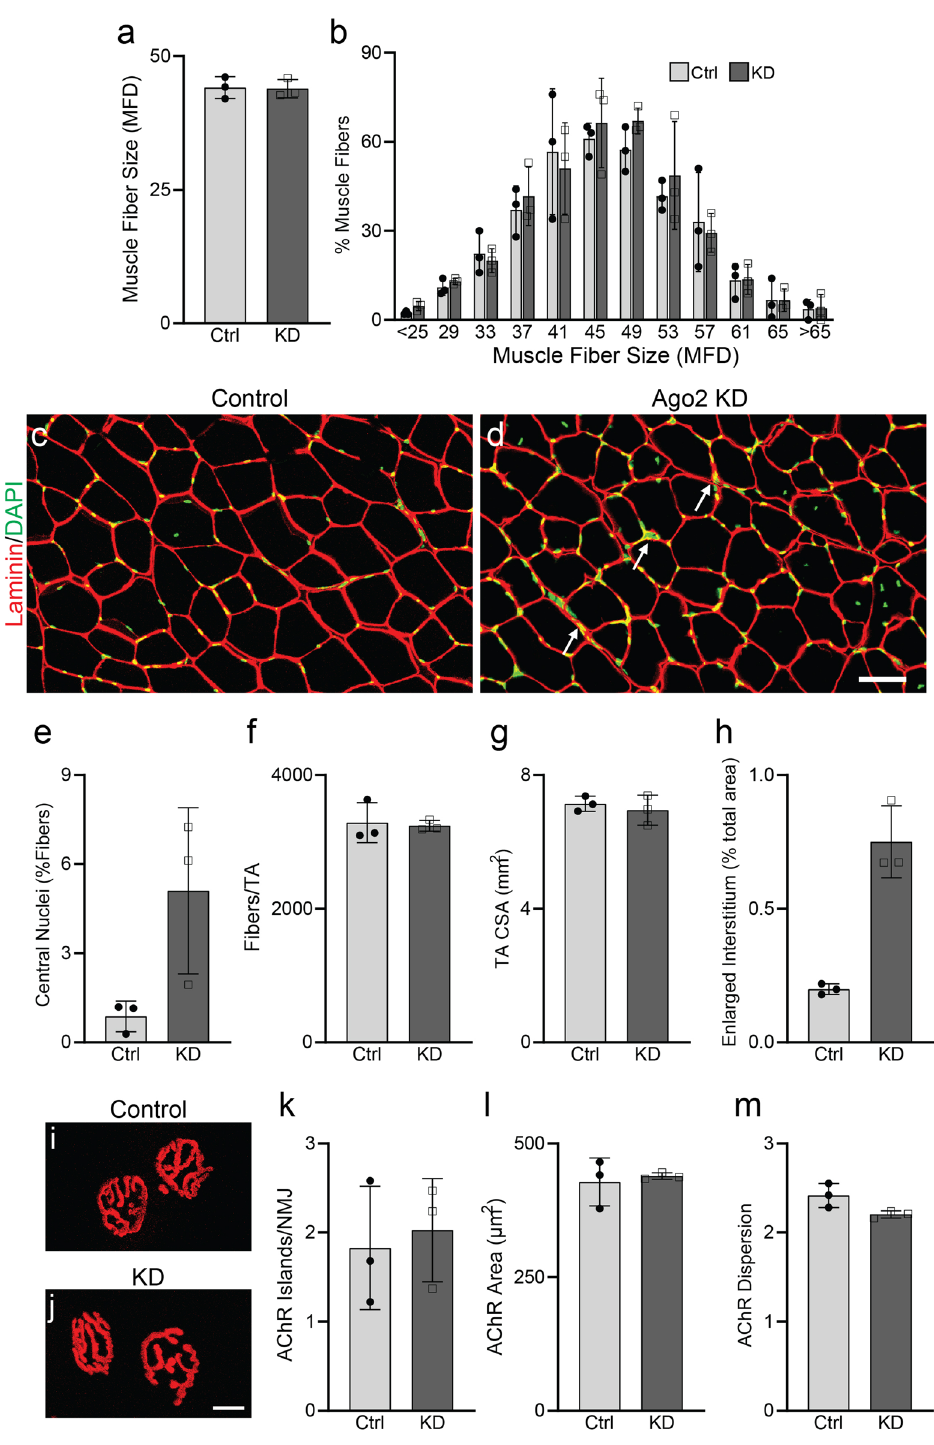
Figure 5. Ago2 knockdown minimally impacts skeletal muscle fiber health in young adult mice. Ago2 fl/fl mice received control- eGFP or Cre AAVs to contralateral TAs at P17. ( a – h ) Histological analysis of TAs performed at 3 months post-infection. ( a ) Mean muscle fiber size, assessed by measurement of minimum Feret’s diameter (MFD) of muscle fiber cross sections identified by laminin IHC. ( b ) Distribution of TA muscle fiber sizes. ( c , d ) Representative images of laminin (red) IHC of TA muscle cross sections collected from control ( c ) and Ago2 KD ( d ) legs. Arrows indicate areas of thickened interstitial space with nuclei. ( e ) Percentage of muscle fibers with centrally located nuclei. ( f ) Number of muscle fibers per TA cross section. ( g ) Cross-sectional area (CSA) of TA muscles. ( h ) Percentage of TA CSA containing thickened interstitial space. ( i , j ) Representative images of fBTX-labeled AChR clusters in control ( i ) and Ago2 KD ( j ) EDL muscles. ( k ) Number of AChR islands per NMJ. ( l ) Area of NMJ AChR area. ( m ) AChR cluster dispersion. All values reported as mean ± SD. Unpaired 2-sided t test used for all comparisons except panels ( e ) and ( l ), where unpaired 2-sided t test with Welch’s correction was used, and panel ( h ), where Mann–Whitney test was used. n = 3. Scale bar = 10